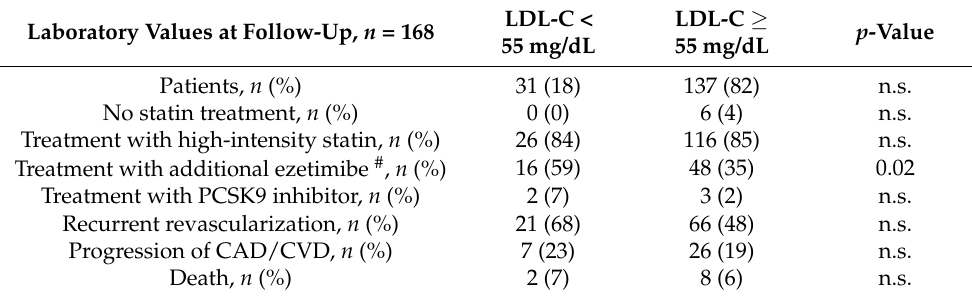
Table 4. Follow-up data on LDL-C target level